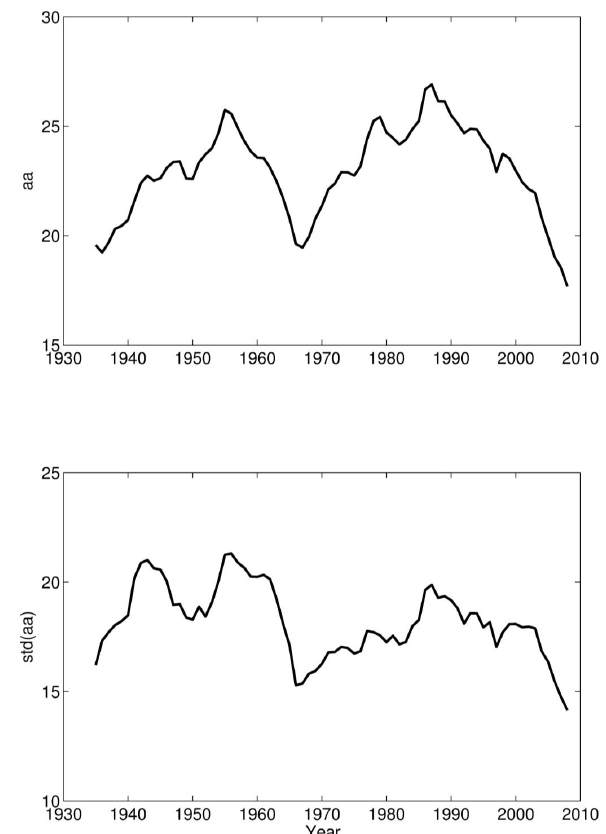
Fig. 6. Time series of annual mean values (top panel) and annual Figure 6. Time series of annual mean values (top panel) and annual standard deviation 2 standard deviation (lower panel) of the geomagnetic aa index. For (lower panel) of the geomagnetic aa index. For both these parameters, annual values were 3 both these parameters, annual values were calculated from daily data and then smoothed with an eleven-year running window for calculated from daily data and then smoothed with an eleven year running window for 4 comparison with Figs. 4 and comparison with figures 4 and 5. 5